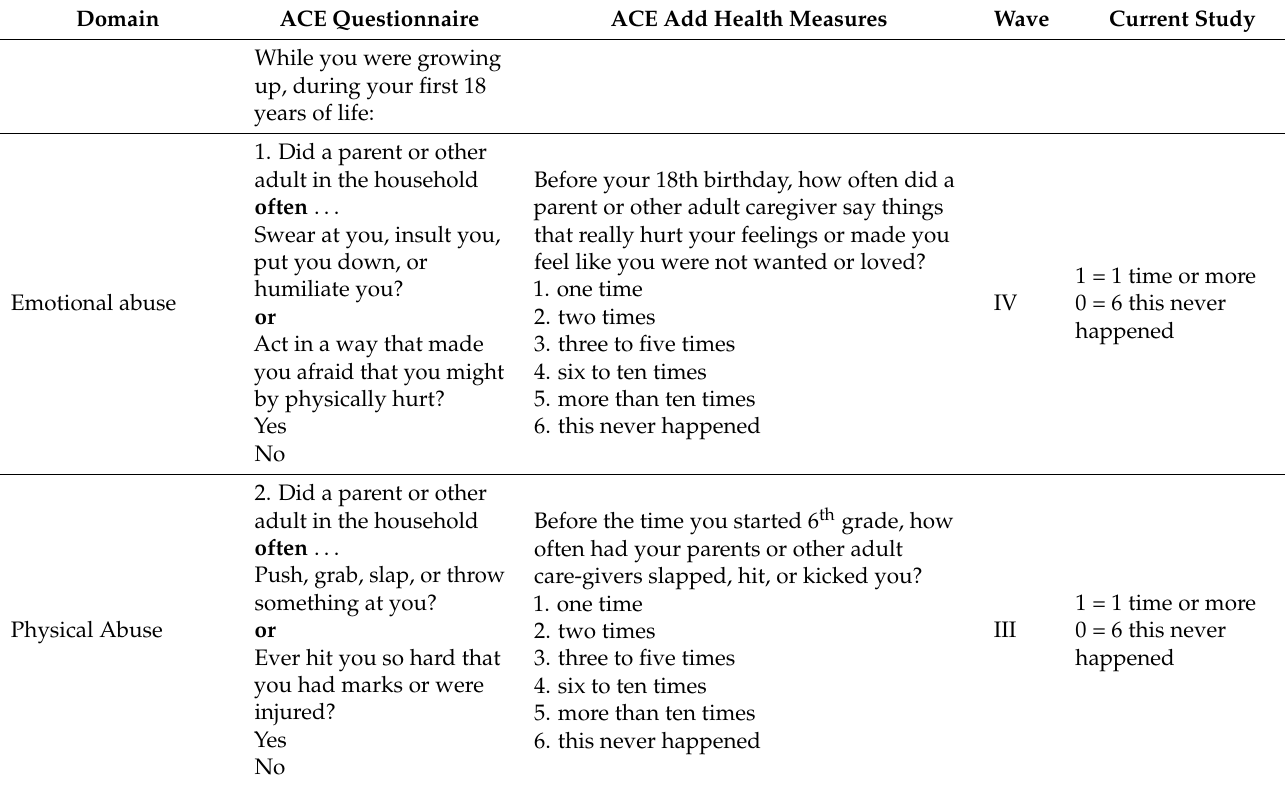
Table A1. ACE Questionnaire and ACE Add Health